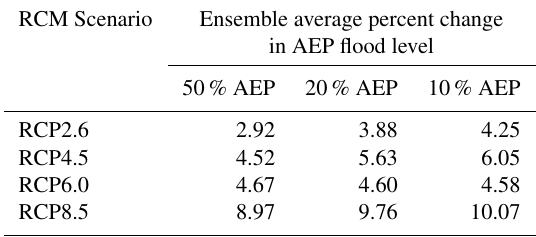
Table 4. Ensemble catchment average percentage change in 50%, 20% and 10% annual exceedance probability (AEP) flood levels for all RCM scenarios (a positive value indicates an increase in mean annual water level within the hydrological